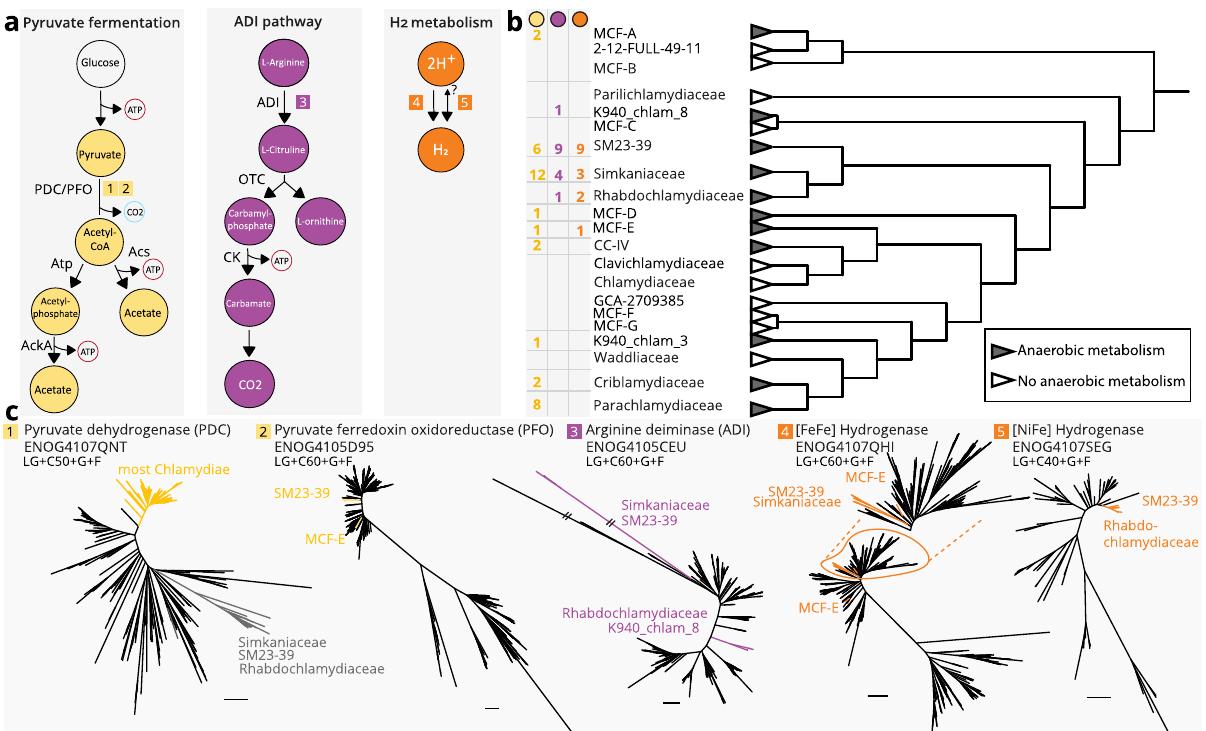
Fig. 5 Widespread fermentation pathways and molecular hydrogen production in chlamydiae. a Representation of putative anaerobic pathways for ATP generation and molecular hydrogen metabolism in chlamydiae. Labels next to enzymatic reactions indicate the associated enzymes. Numbers in squares correspond to phylogenetic trees in ( c ). Colors indicate af fi liation with different pathways — pyruvate fermentation (yellow), ADI pathway (violet), hydrogen metabolism (orange). b Species tree of chlamydial representative genomes as in Fig. 3 collapsed at the family rank. Branch support values are based on 100 non-parametric bootstraps, support ≥ 70% is indicated as black circles. Box next to family names indicates the number of non-redundant genomes in a family with the respective color coded metabolic pathway. Pyruvate fermentation to acetate was only counted if genes encoding the complete pathway were present, i.e., pyruvate dehydrogenase complex (PDC), or pyruvate ferredoxin oxidoreductase (PFO) together with phosphate acetyltransferase (Atp) and acetate kinase (AckA), or acetate-CoA ligase (Acs). Likewise, arginine deaminase (ADI) pathway was only counted if genes encoding arginine deaminase (ADI), ornithine carbamoyltransferase (OTC), and carbamate kinase (CK) were present in a genome. c Unrooted maximum likelihood phylogenetic trees with best fi t models numbered and colored according to ( a ) with 1000 optimized ultrafast bootstrap and 1000 SH-like approximate likelihood ratio test support. Best fi t models per gene are indicated under the gene name and clades are named by